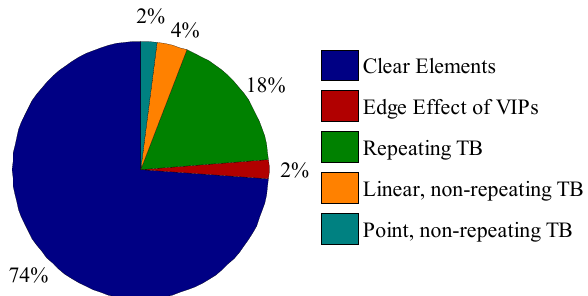
Figure 5. Contribution of thermal bridges (TB) on the direct heat transfer coefficient, H D .